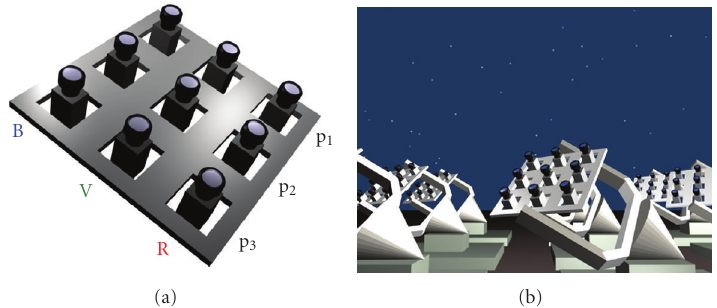
Figure 8: (a) Basic 3 × 3 objective unit. Each objective is able to repoint independently and has installable color and polarization filters. (b) The artistic view of a complete MegaTORTORA system, consisting of a number of basic units on separate equatorial mounts.